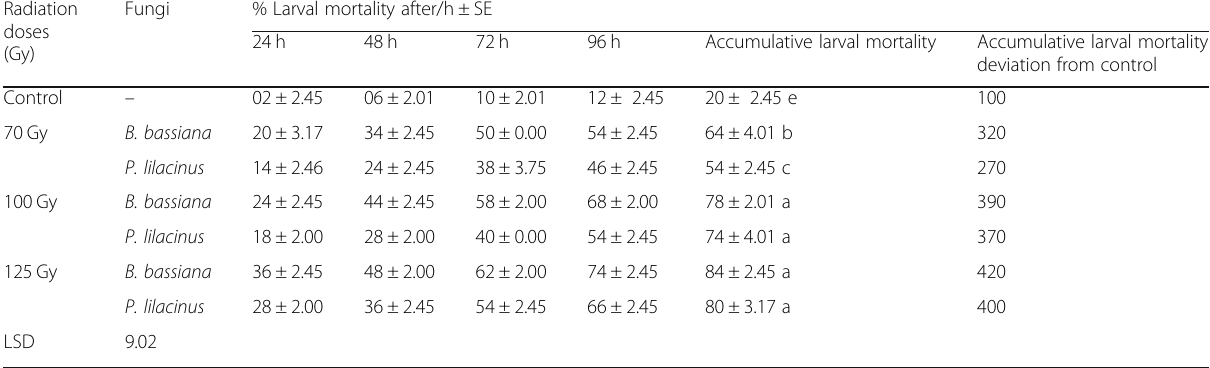
Table 6 Effect of gamma irradiation combined with the LC 50 of the entomopathogenic fungi; Beauveria bassiana and Paecilomyces lilacinus on the percentage larval mortality of Galleria mellonella descending from the irradiated parental females as